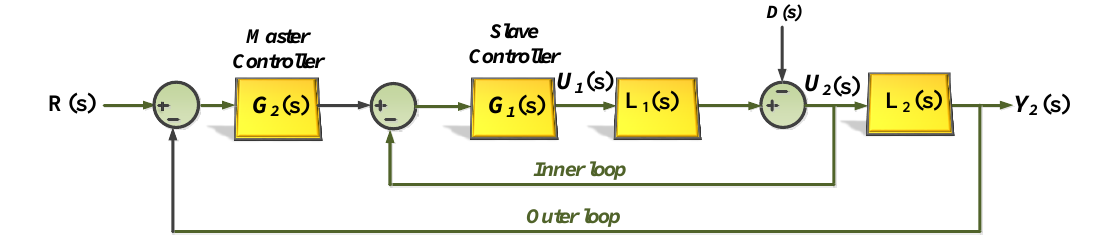
Figure 3. Structure of the cascade controller.